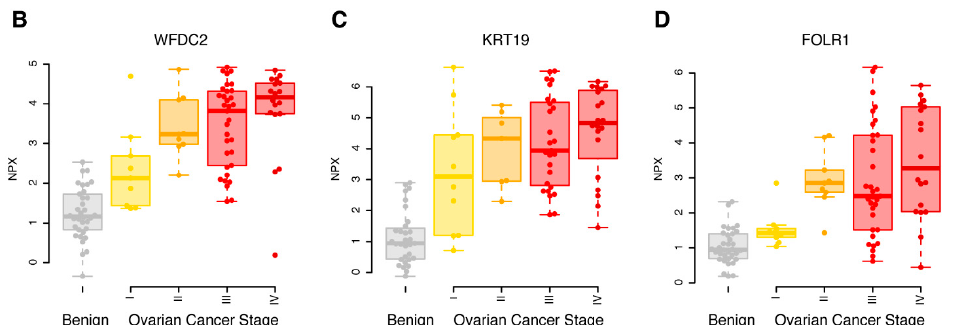
Figure 1. Univariate results in the discovery cohort. ( A ) Mean differences in NPX (controls–cases) are shown on the x -axis and p -values ( − log10, two-sided Wilcoxon ranked test) on the y -axis. Proteins plotted in red were significantly different in the discovery data (q < 0.05, Bonferroni adjusted, and a foldchange of at least 1 NPX). Light grey dashed lines represent cut-offs for p -value and foldchange. Proteins marked with a ‘+’ were also found to be significant (q < 0.05, Bonferroni adjusted, foldchange of at least 1 NPX) in the replication data. The five proteins with the lowest p -values in the discovery data are labelled. ( B ) Beeswarm plots of individual protein measurements for WFDC2 in the discovery cohort. The top and bottom of the overlayed boxplots represents the 25th and 75th percentile and the band inside the box the median value. Outliers were omitted from the boxplots. The samples are divided by diagnoses: B—benign (coloured grey), I, II, III and IV—ovarian cancer FIGO stage (coloured yellow to red). ( C ) As ( B ), but for KRT19. ( D ) As ( B ), but for